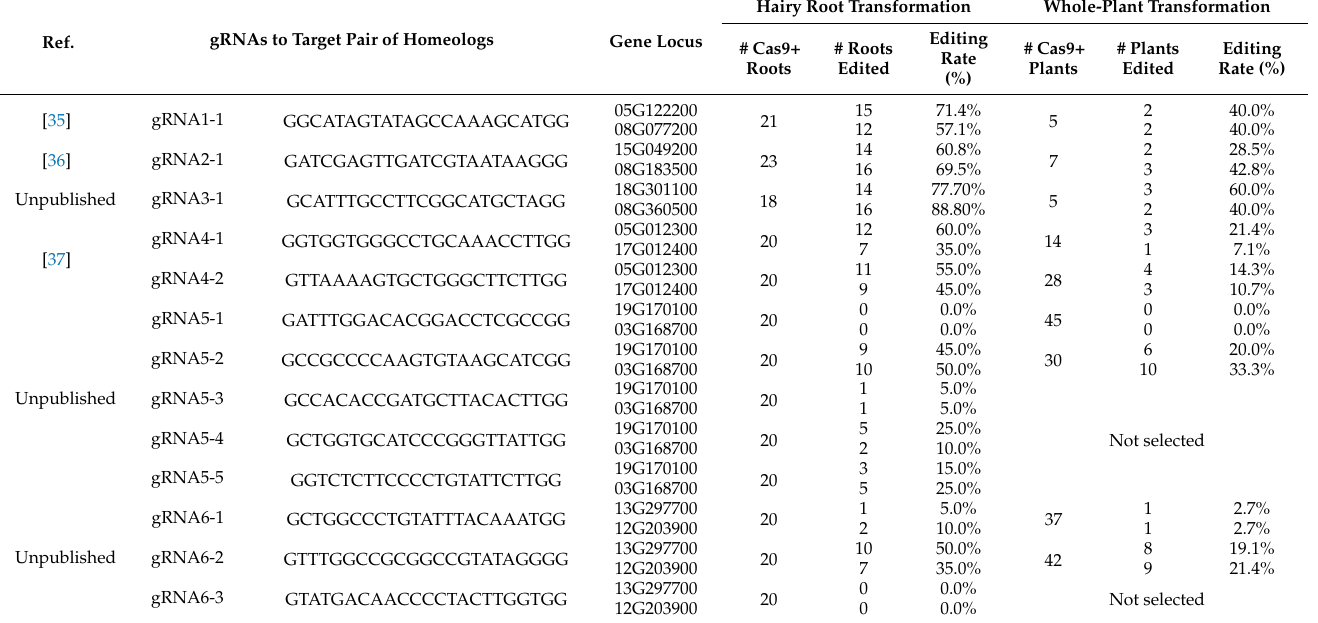
Table 4. Gene-editing efficiency of gRNA1-6 in hairy root and whole-plant transformation.